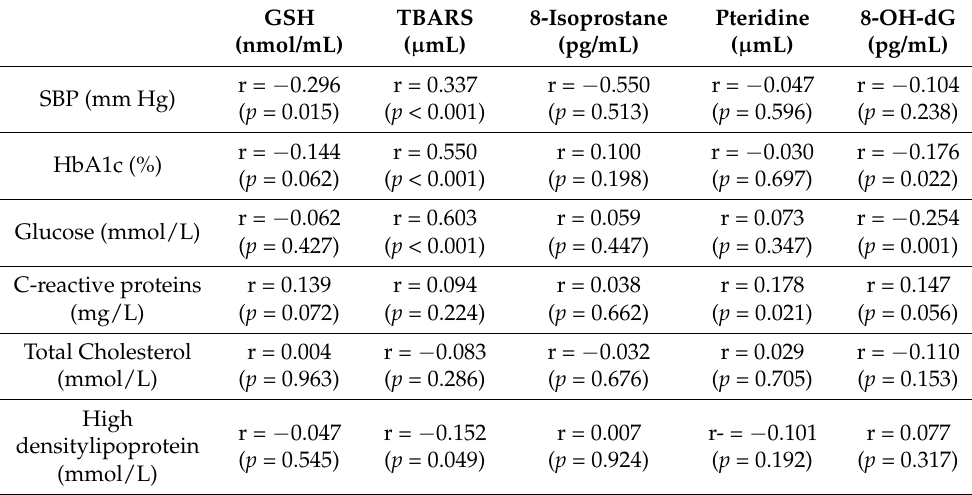
Table 3. Correlation between metabolic risk factors and oxidative damage markers.